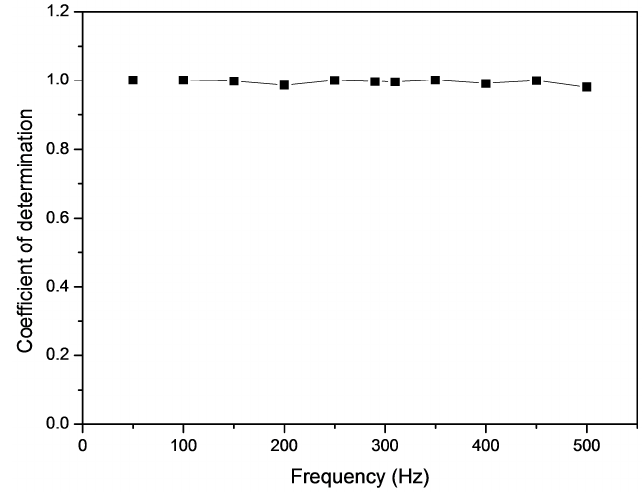
Figure 10. The coefficient of determination (R 2 ).